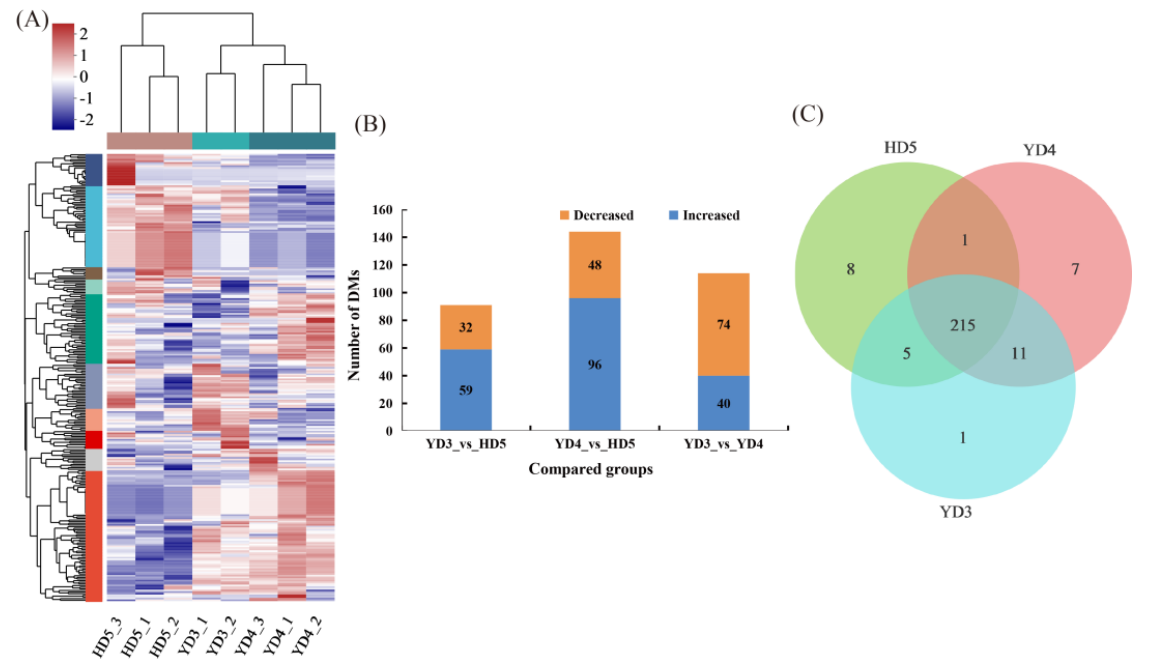
Figure 2 . Hierarchical clustering heatmap and metabolite analysis. ( A ) Hierarchical clustering heatmap among three japonica rice samples; ( B ) pairwise comparison of differential metabolites; and ( C ) metabolite Venn distribution map.